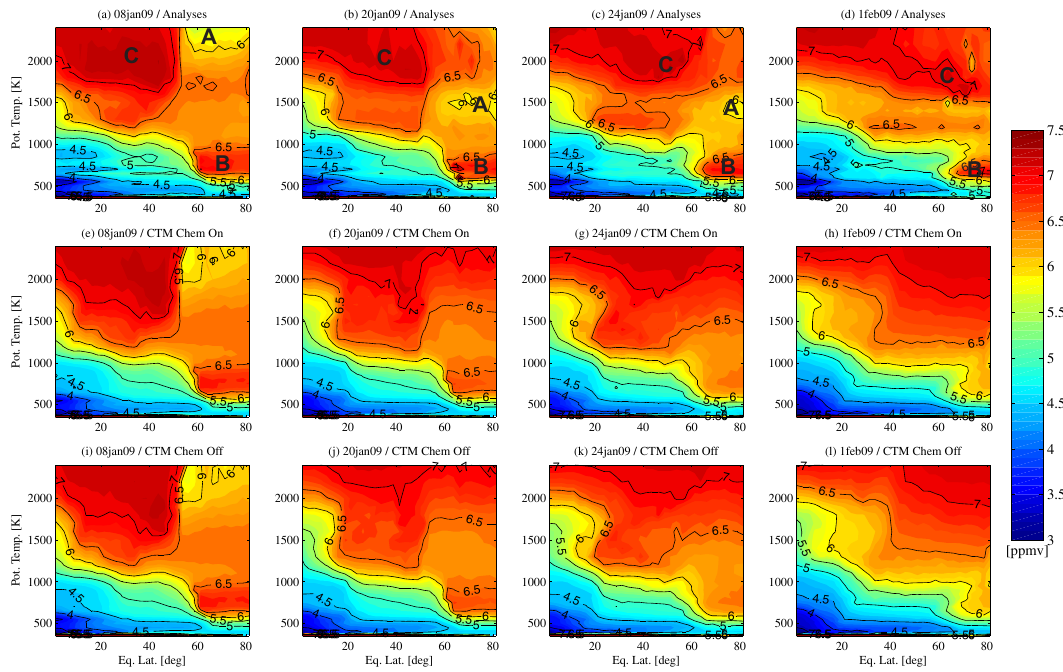
Fig. 8. Equivalent latitude-theta plots of water vapour fields at 12:00UTC (ppmv). Top row: BASCOE analyses; middle row: BASCOE CTM run (no assimilation), with chemistry; bottom row: BASCOE CTM run (no assimilation), no chemistry. Left column: 8 January 2009; middle left column: 20 January 2009; middle right column: 24 January 2009; right column: 1 February 2009. Red indicates relatively high values; blue indicates relatively low values. A, B and C in the top row plots identify features discussed in the text, and mentioned in Table